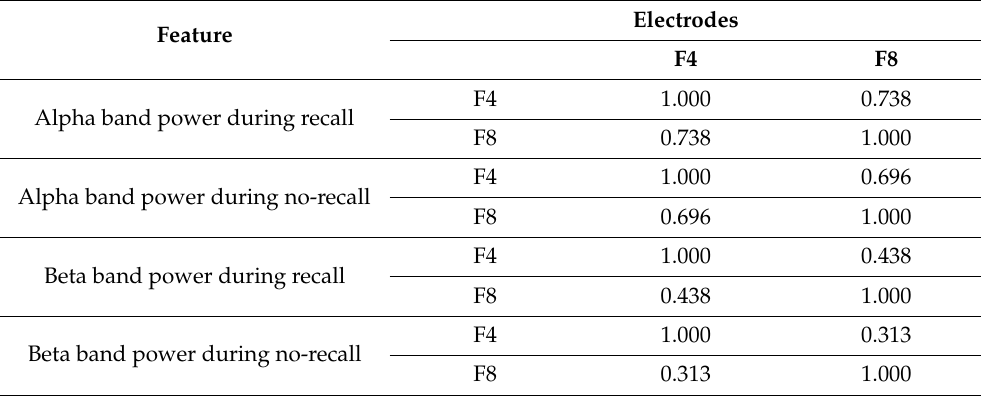
Table 6. Pearson correlation coefficient results for F4–F8 paired